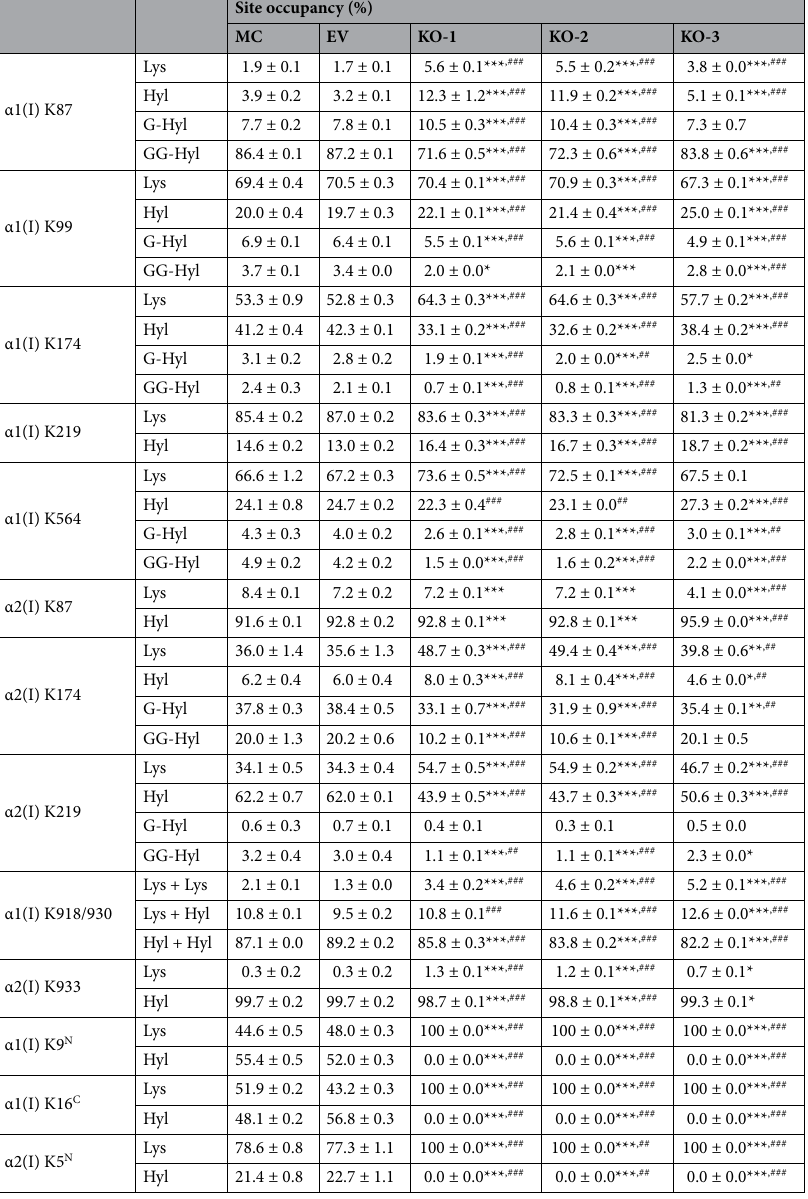
Table 3. Summary of site-specific modification analysis by mass spectrometry of non-cross-linked, hydroxylated and glycosylated residues in type I collagen from controls (MC and EV) and KO clones. Lys hydroxylation and its glycosylation (%) represents the relative levels of Lys, Hyl, G-Hyl, and GG-Hyl (Lys + Hyl + G-Hyl + GG-Hyl = 100%). Values represent mean ± S.D. (n = 3) of triplicate analysis for each group. Statistical differences were determined by Kruskal–Wallis one-way analysis of variance and means comparison with the controls by Dunnett’s method. Lys lysine, Hyl hydroxylysine, G- galactosyl-, GG- glucosylgalactosyl, MC MC3T3-E1, EV empty vector, KO knock-out. *p < 0.05, **p < 0.01, and ***p < 0.001 between MC and KO; ## p < 0.01 and ### p < 0.001 between EV and KO,